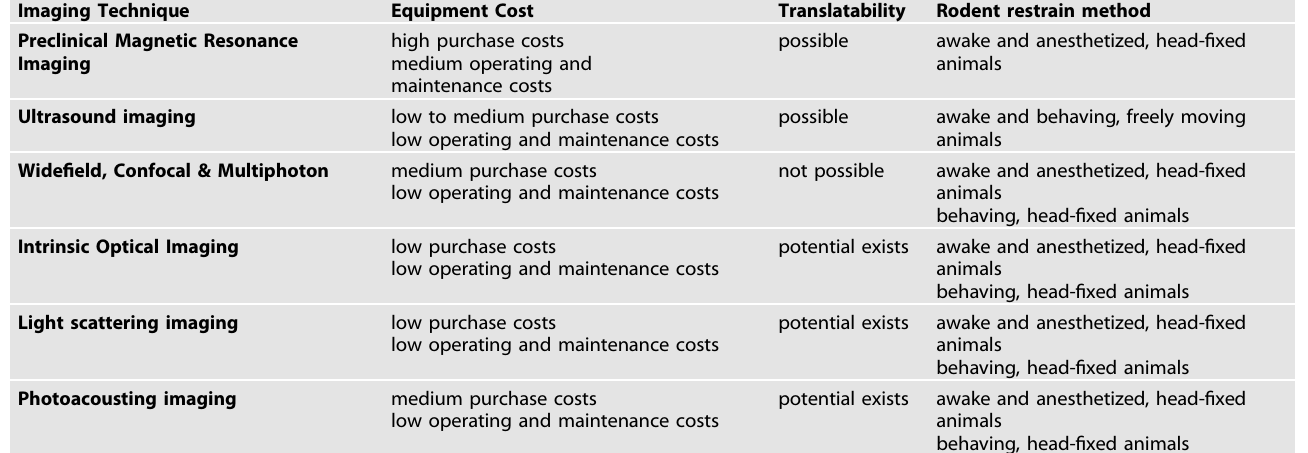
Table 1. Table summarizing the costs, the major technical dif fi culties, the translatability, and the type of restraining method of each